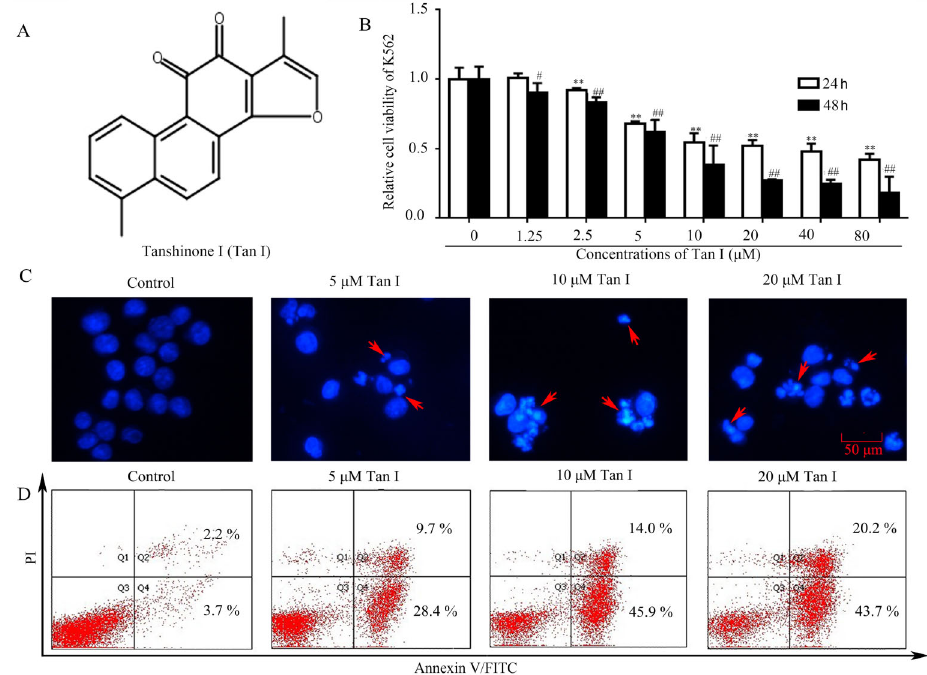
Figure 1. Tanshinone I treatment inhibited growth and induced apoptosis in human chronic myeloid leukemia K562 cells. A , The chemical structure of Tan I. B , Effect of Tan I concentration on K562 cell viability, comparing 24 and 48 h of exposure. C , Bright nuclear condensation and perinuclear apoptotic bodies were captured by fl uorescent microscopy (scale bar 50 m m). D , Apoptosis rate of K562 after the treatment of different concentrations of Tan I. Data are reported as means ± SD. **P o 0.01 compared with the control group at 24 h; # P o 0.05 and ## P o 0.01 compared with the control group at 48 h